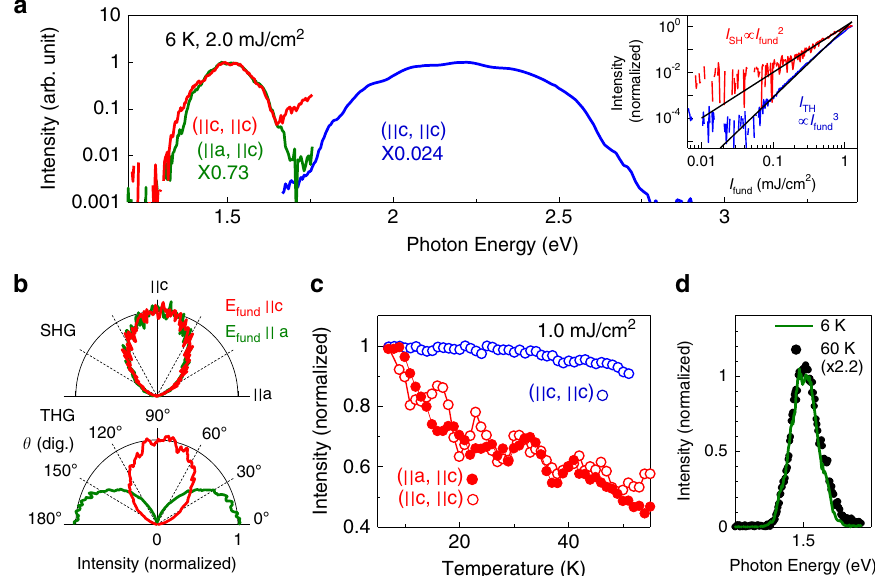
Fig. 2 SHG and THG spectra of κ -(BEDT – TTF)2Cu[N(CN)2]Br, and their polarization and temperature dependences. a The red and green lines indicate the SHG spectra of single crystalline κ -(BEDT – TTF) 2 Cu[N(CN) 2 ]Br (6 K) for the polarizations of ( E fund | | c , E SH | | c ) (red line) and ( E fund | | a , E SH | | c ) (green line, ×0.73). The blue line shows the THG spectrum (×0.024) for ( E fund | | c , E TH | | c ). The intensity of the fundamental light ( I fund = E fund 2 ) is 2 mJ/ cm 2 . Inset shows I fund dependences of I SH (red line for E fund | | c , E SH | | c ) and I TH (blue line for E fund | | c , E TH | | c ). b Polarization dependences of I SH (upper panel) and I TH (lower panel) for E fund | | c (red line) and E fund | | a (green line), respectively. c Temperature dependences of I SH (closed red circles: E fund | | a , E SH | | c , open red circles: E fund | | c , E SH | | c ) and I TH (open blue circles, E fund | | c , E TH | | c ). Both are normalized by the respective intensities at 6 K. d SHG spectra ( E fund | | a , E SH | | c ) at 6 K (green line) and at 60 K (black dots).